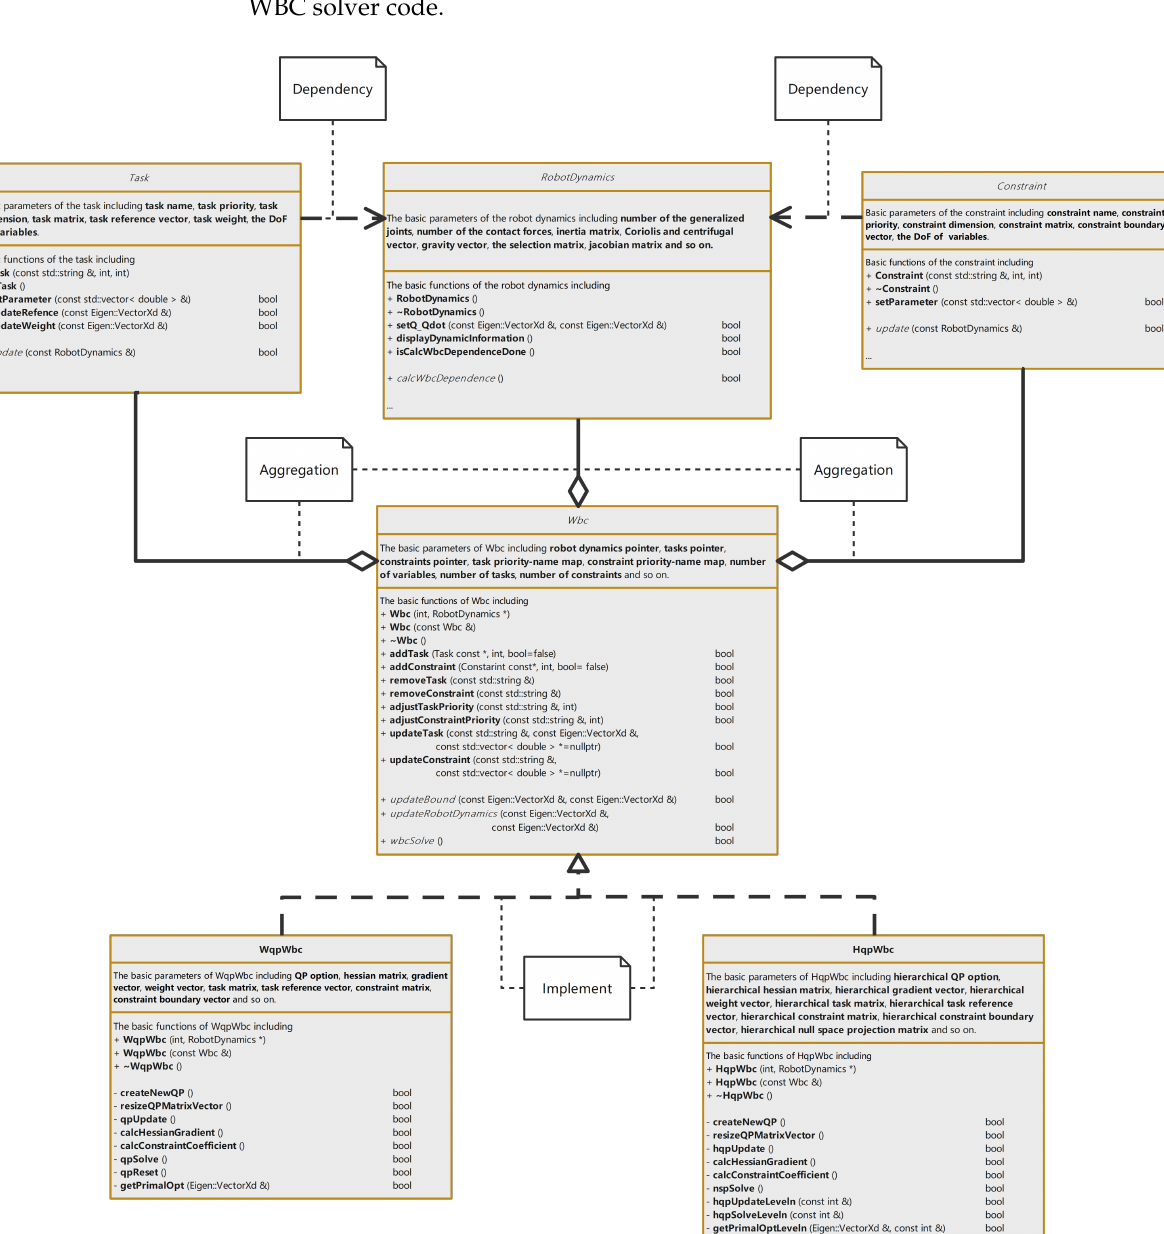
Figure 3. The architecture of WBC